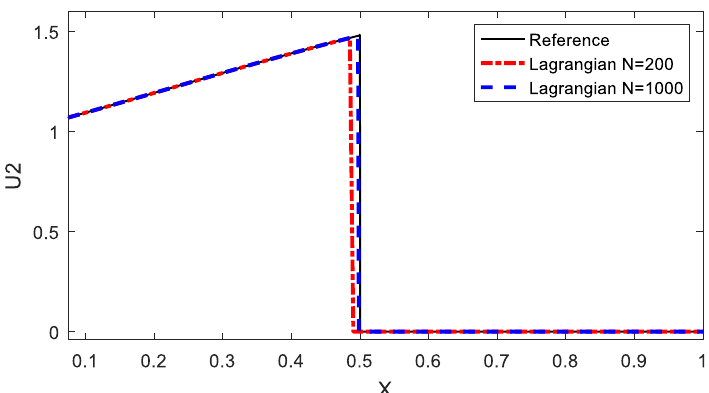
Figure 5. Concentration profile of species A at t = 0.5 solved by the Lagrangian particle method with different particle numbers.